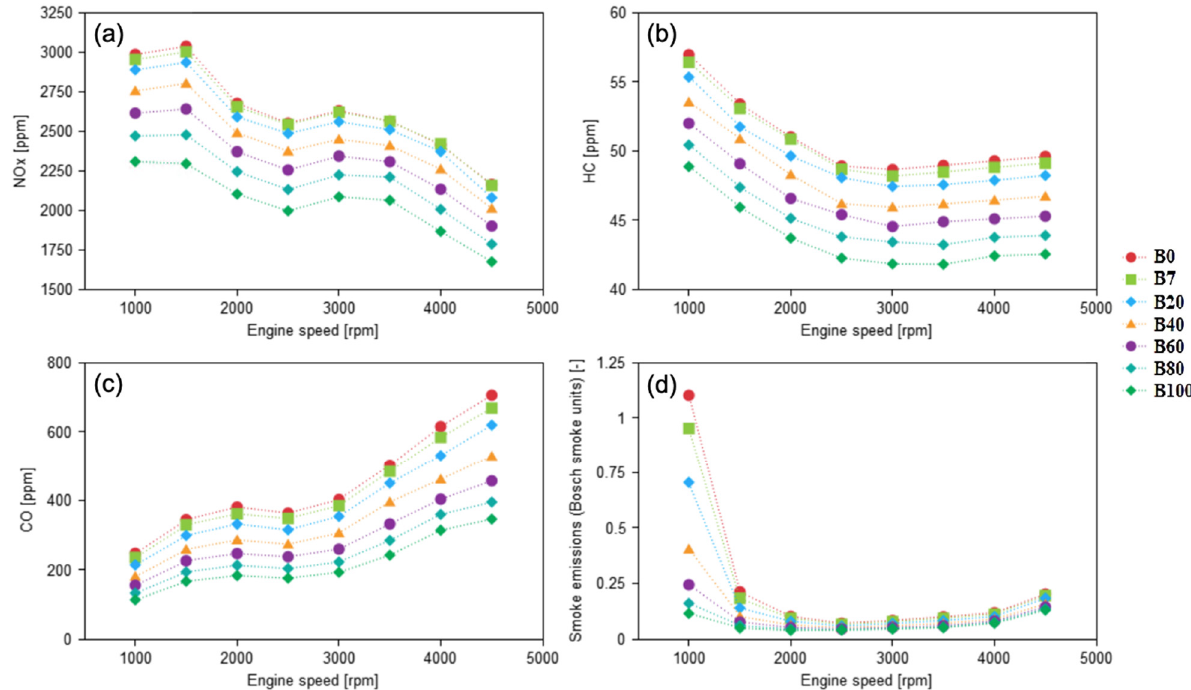
Figure 10. Comparison of emissions ( a ) NO x , ( b ) HC , ( c ) CO , and ( d ) soot, with different diesel– biodiesel blends.